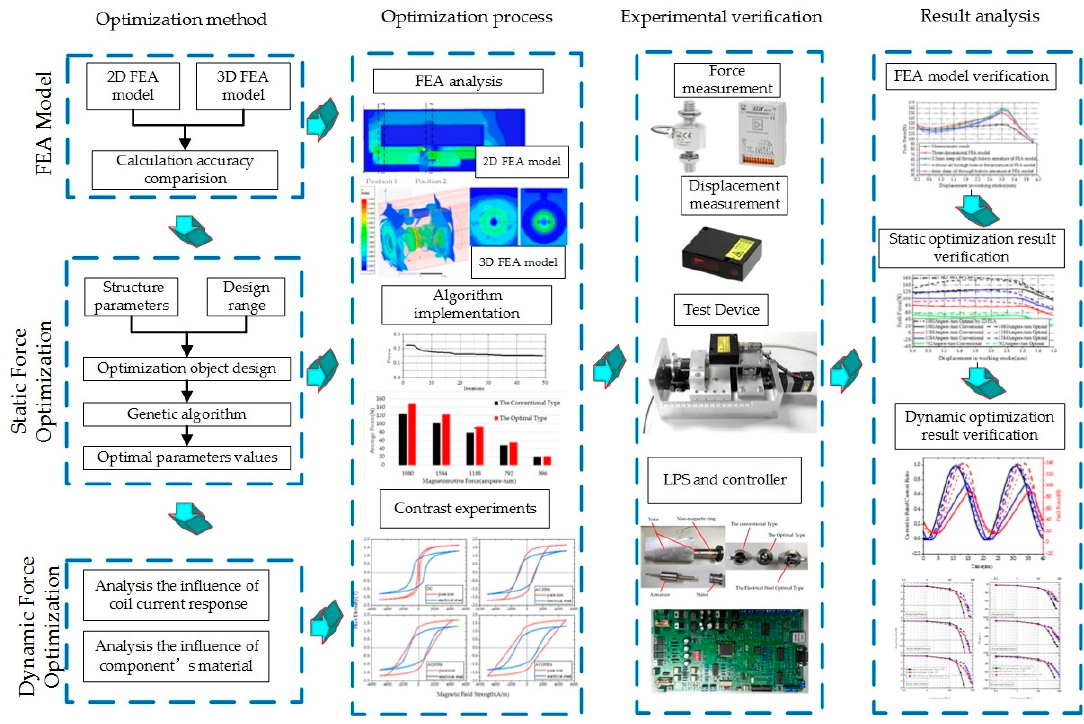
Figure 1. Overall description of this performance optimization strategy.